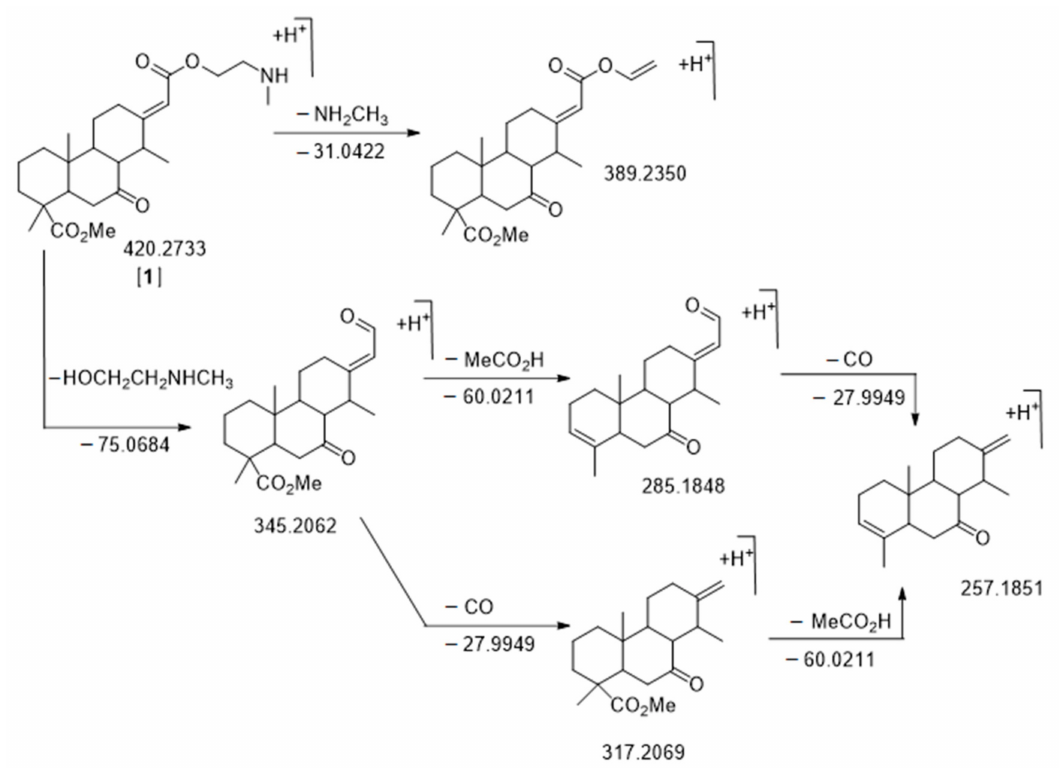
Figure 4. Fragmentation pattern of C 24 H 37 NO 5 m / z 420.2733 RT = 16.97 min, nor -cassamine [ A1 ]. The m / z values of neutral loss are calculated while the m / z values of fragments are observed. All δ ppm are under 20